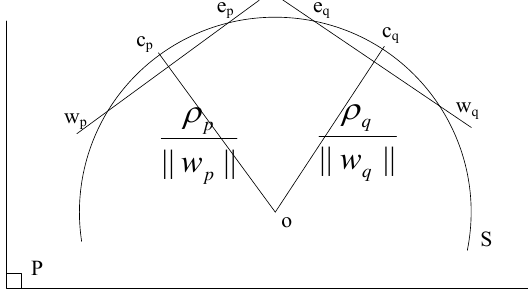
Figure 2 Sketch map of the high-dimensional feature space